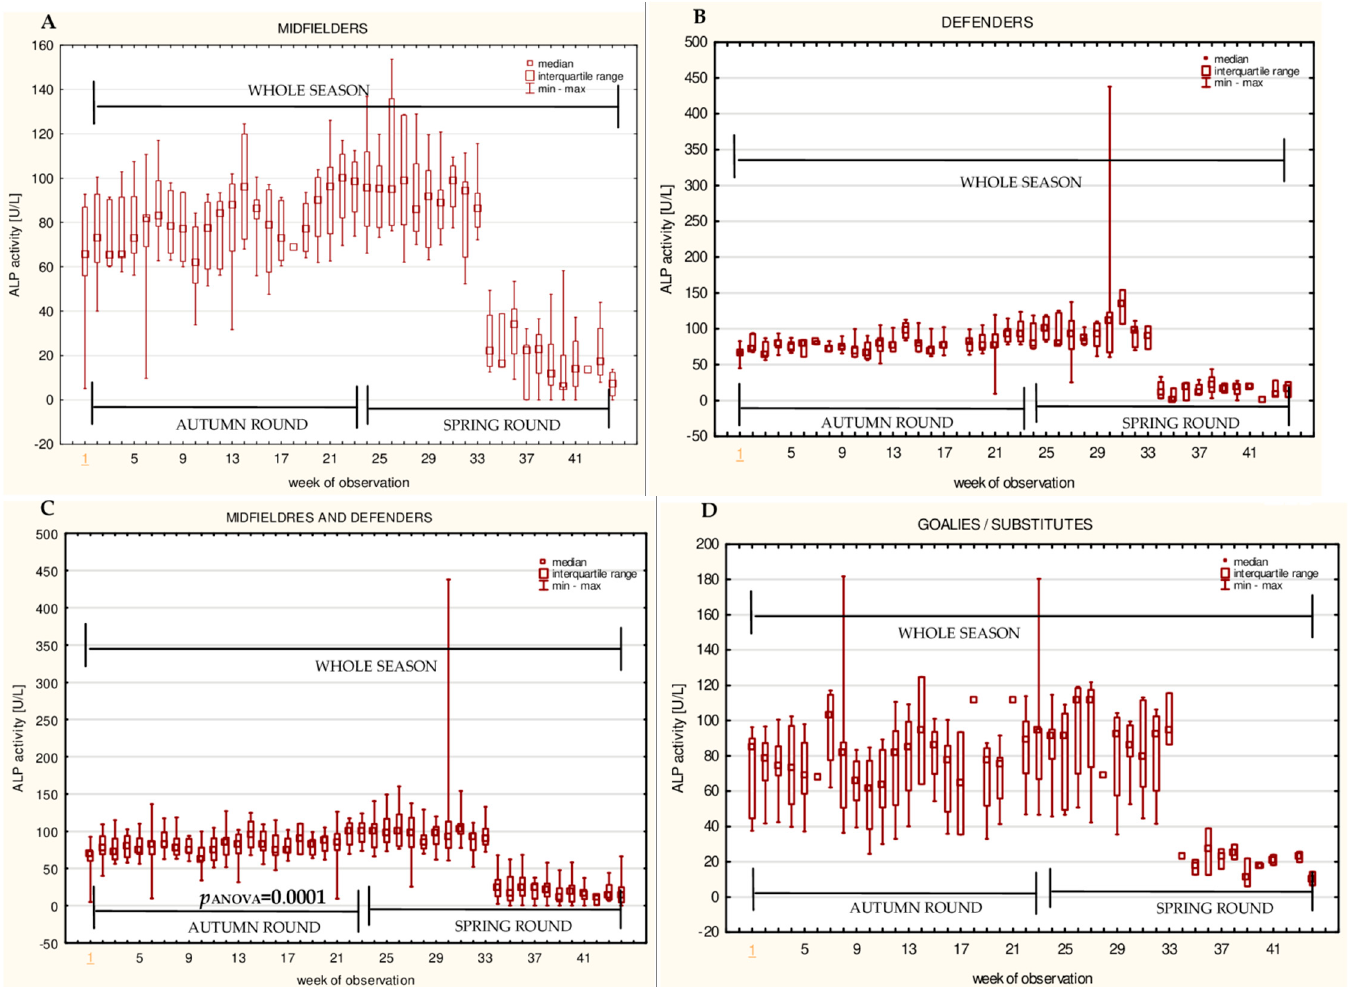
Figure 5. Median alkaline phosphatase(ALP) activities in: ( A ) The midfielder, ( B ) defender, ( C ) midfielder / defender and ( D ) goalie / substitutesubgroups over the course of the soccer match